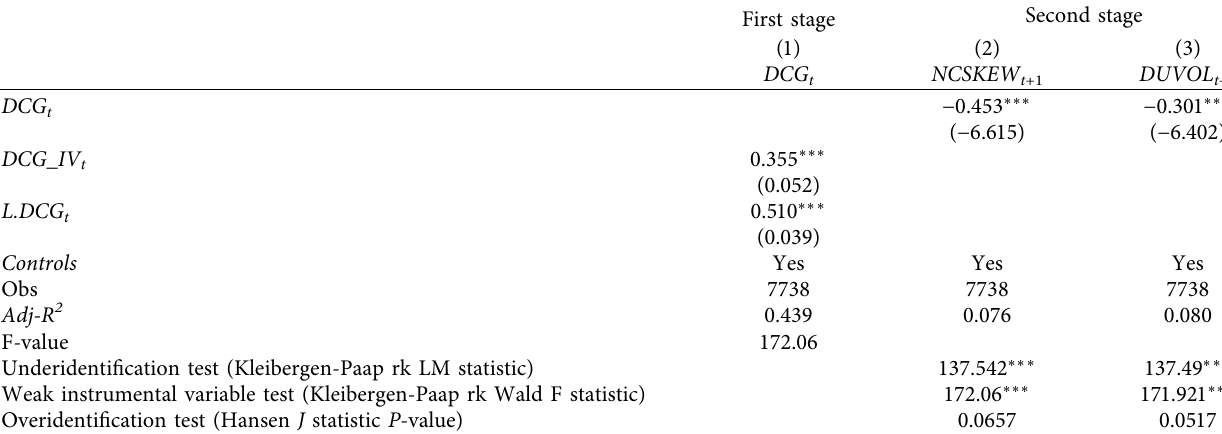
Table 7: Endogenous problems: 2SLS.